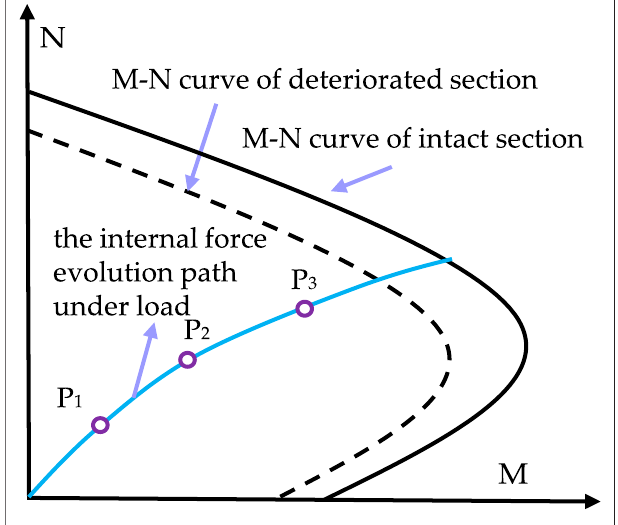
FIGURE 14 | Degradation mechanism of section strength considering material